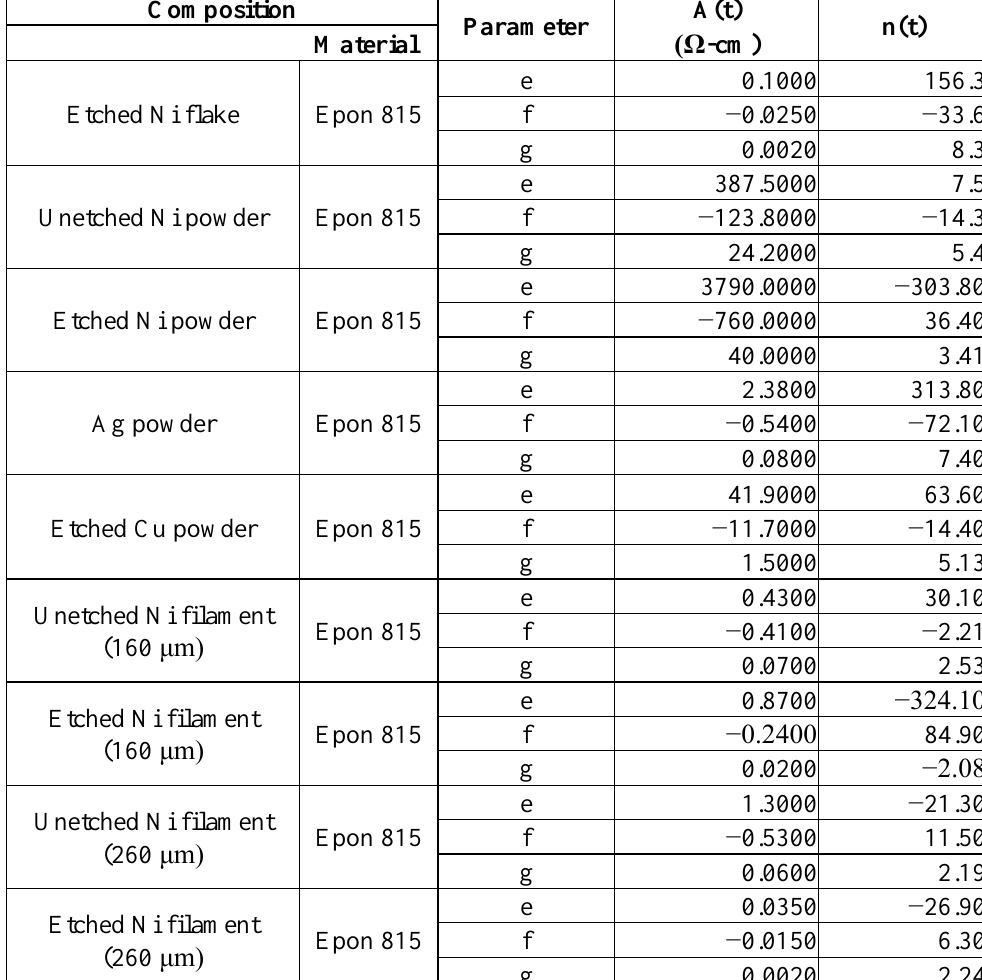
Table 7. The parameters e, f and g of Equation 18 for A(t) and n(t) with various filled Epon 815C adhesive